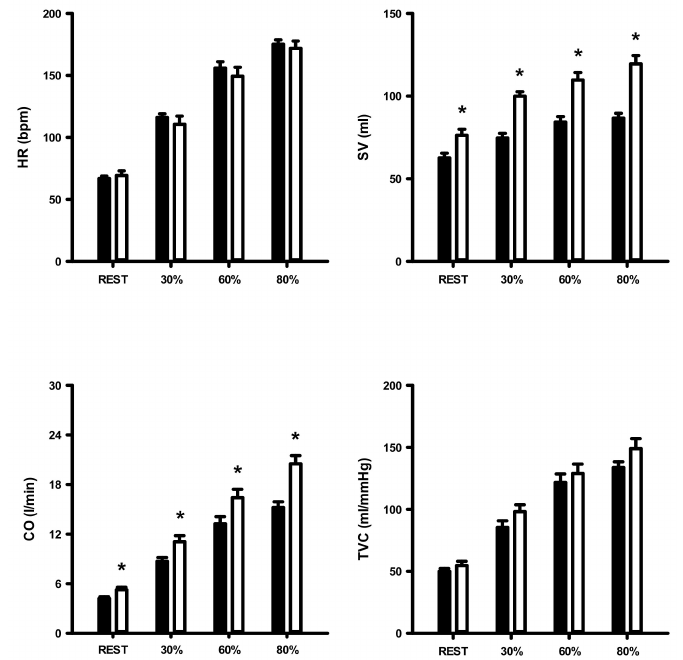
Figure 6. Heart rate (HR), stroke volume (SV), cardiac output (CO), and total vascular conductance (TVC) at rest and during dynamic exercise in both normal and obese individuals. Black bar, normal; open bar, obese. * p < 0.05, vs. normal